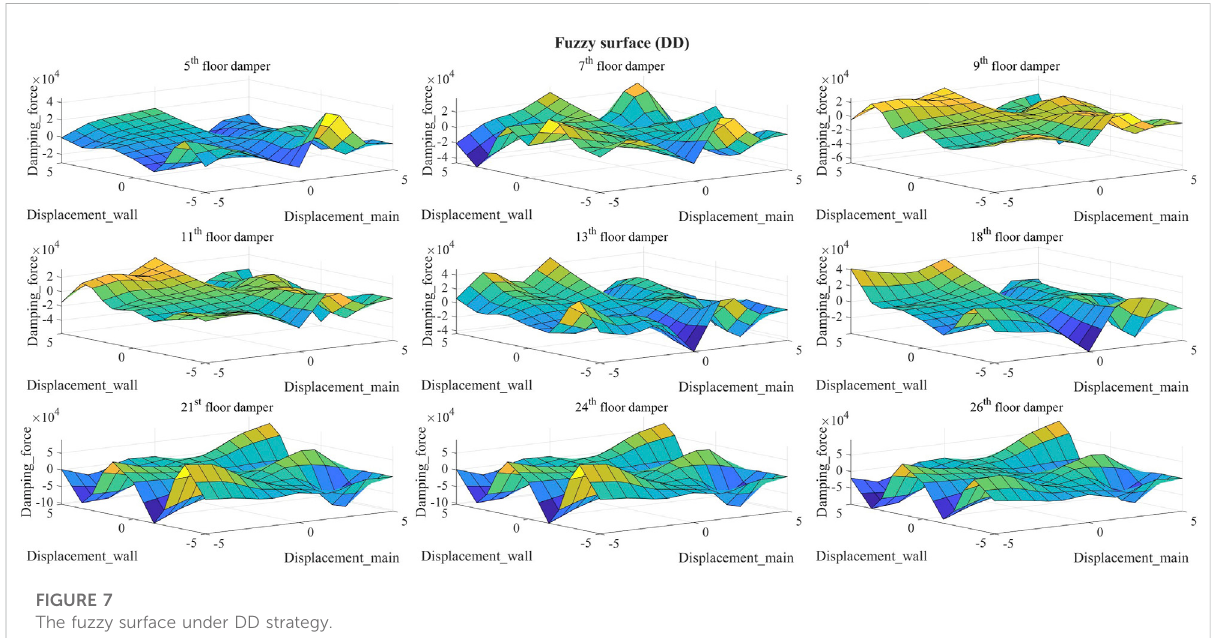
FIGURE 7 The fuzzy surface under DD strategy.